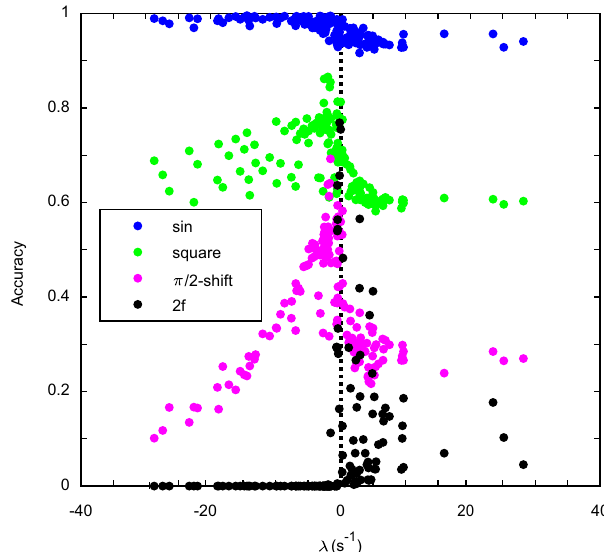
Fig. 8 Network performance in non-linear transformation task for different dynamical regimes. Accuracy of transformation of input triangular wave into different target waves: sinusoidal (blue), square (green), π /2 phase-shifted triangular (pink) and double frequency (2 f ) triangular (black), as a function of the network maximal Lyapunov exponent λ (averaged over all junctions whose state changes while the task is being performed). Vertical line indicates λ = 0. Data-points correspond to individual simulations for a fi xed f and A of the input wave for a 100 nanowire, 261 junction